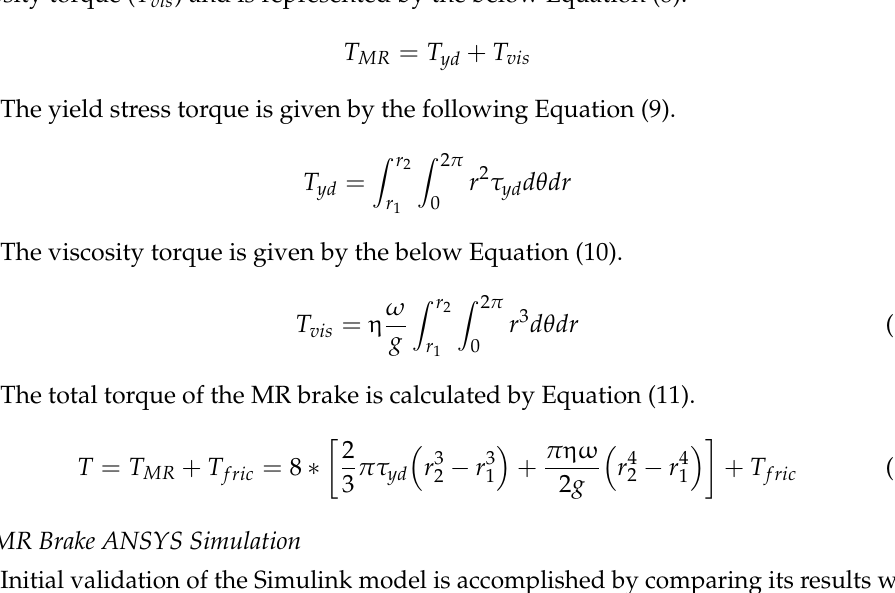
The yield stress torque is given by the following Equation (9).